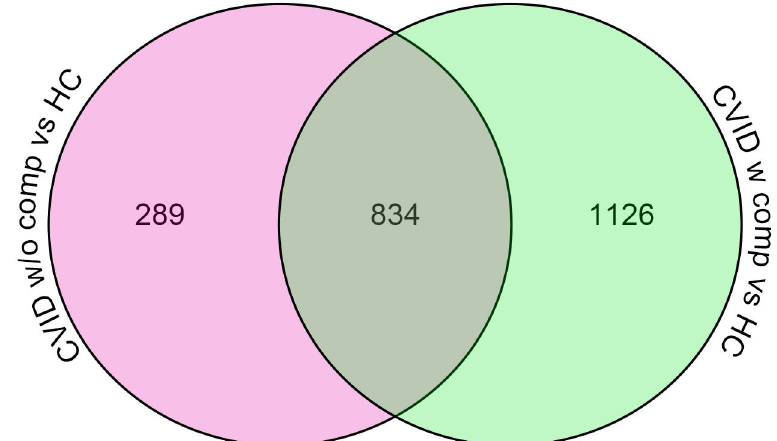
Figure 3. Venn diagram representing the number of common and unique transcripts differentially expressed in patients, compared to healthy controls. Blood from subjects with inflammatory complications contained more upregulated transcripts as compared to those without